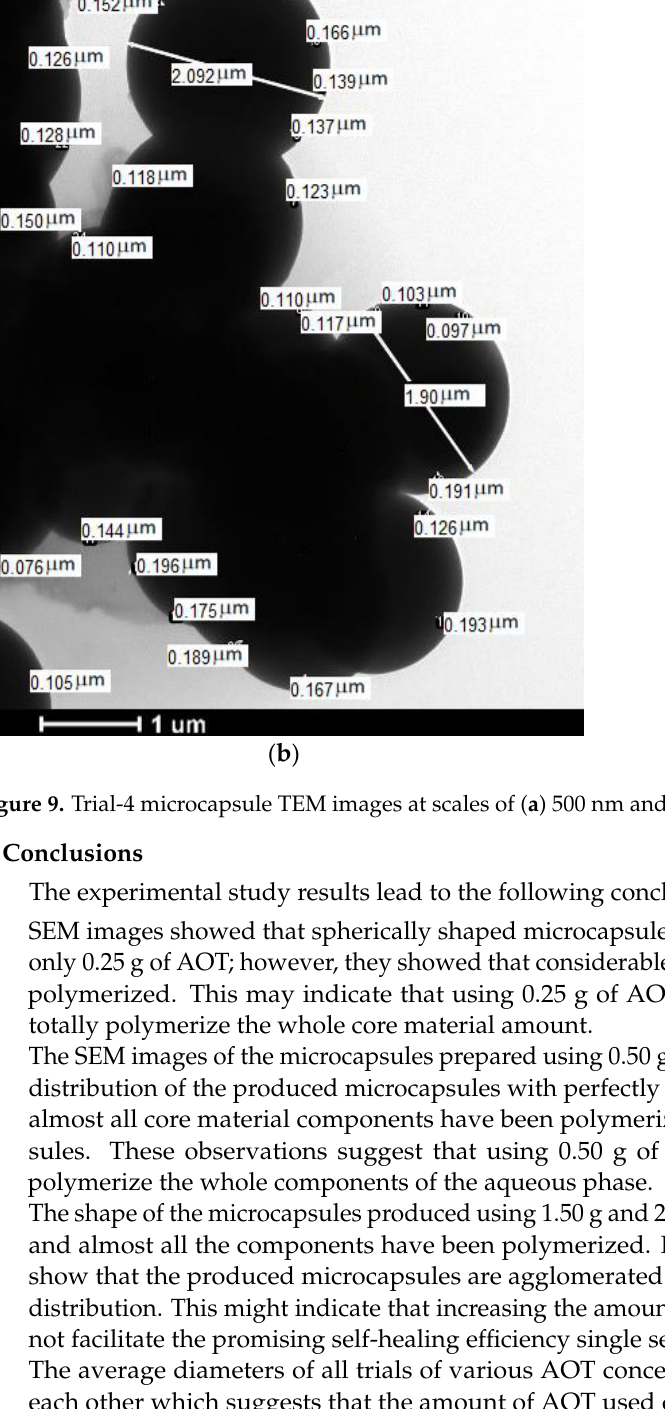
Table 3. Microcapsule average shell thicknesses for all trials at different image scales.